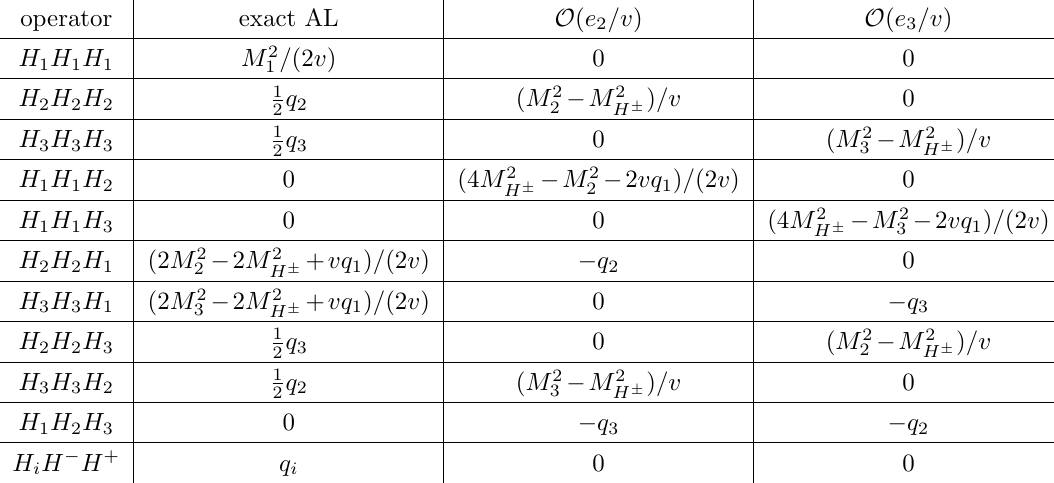
Table 3 . Coe(cid:14)cients of cubic (non-Goldstone) scalar operators expanded around the alignment limit (AL) without decoupling up to O ( e 2 ; 3 =v ). The second, third and fourth columns show the exact alignment result and coe(cid:14)cients of e 2 =v and e 3 =v , respectively. If the alignment limit is realized via decoupling, then certain results of this table are modi(cid:12)ed as shown in table 4.